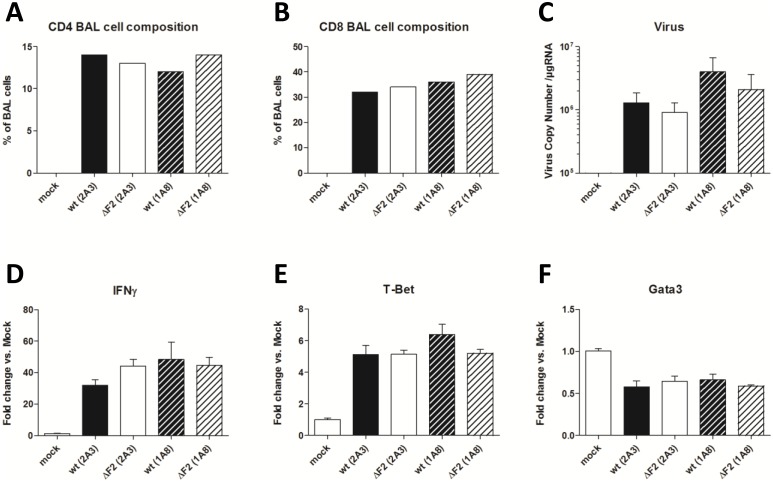
T lymphocytes recruitment is not altered by PB1-F2.Immunocompetent mice (treated with 2A3 antibody) and neutropenic mice (treated with 1A8 antibody) were infected with the wt or the ΔF2 virus. BAL fluids were collected at day 8 pi and the cellular part was characterized by FACS. (A) CD3+ CD11b- CD4+ cell composition of the BAL fluids. (B) CD3+ CD11b- CD8+ cell composition of the BAL fluids. (C) Viral load in lungs expressed as RNA copies normalized to the quantity of RNA used in the experiment. (D-E-F) Total RNA isolated from lungs was reverse-transcribed and used to quantify expression of several T cells markers by qPCR: IFNγ, T-Bet and GATA3. Gene expressions were normalized with the β-actin gene expression level and presented as fold increase relative to mock-treated mice. Results are the mean ± SEM values obtained from 3 animals.